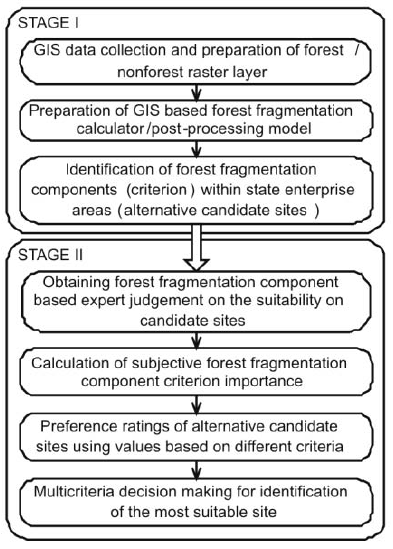
Fig. 1. Decision flowchart for spatial multicriteria analysis